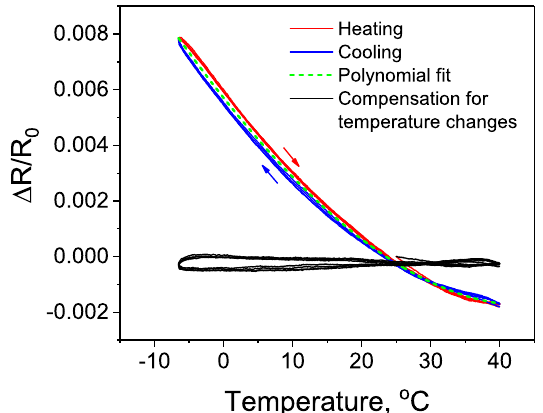
Figure 12. Temperature sensitivity of the developed strain sensor and an example of the compensation for temperature changes based on a reference temperature